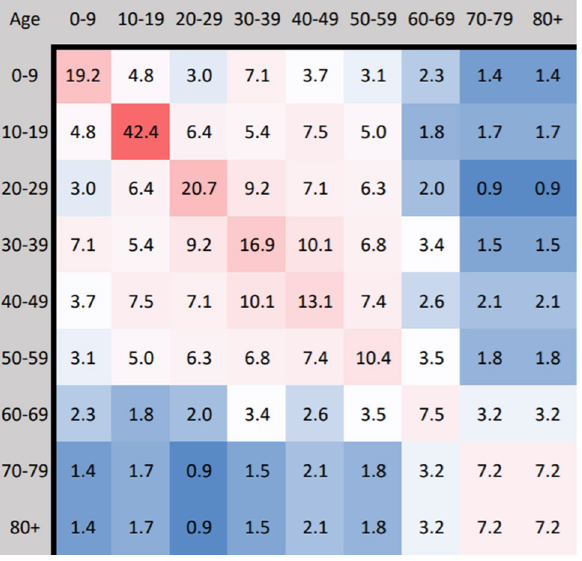
Figure 1. Age-contact matrix M